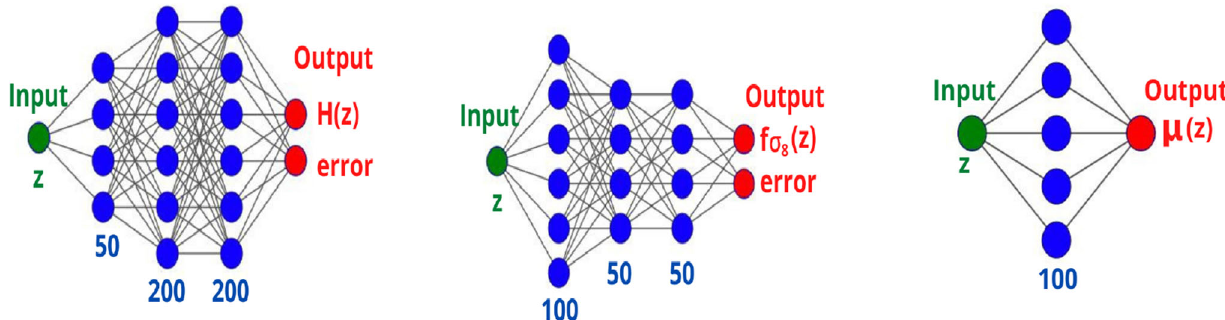
Fig. 1 Neuralnetworkarchitectureschosentomodelthedatafromcos- mic chronometers (CC), f σ 8 measurements and the JLA SNeIa compi- lation, respectively; the batch size found for each case was: 16, 1 and 1. Inthelastarchitecture,thereisonlyonenodeintheoutputlayerbecause the errors are computed with a variational autoencoder (described in the